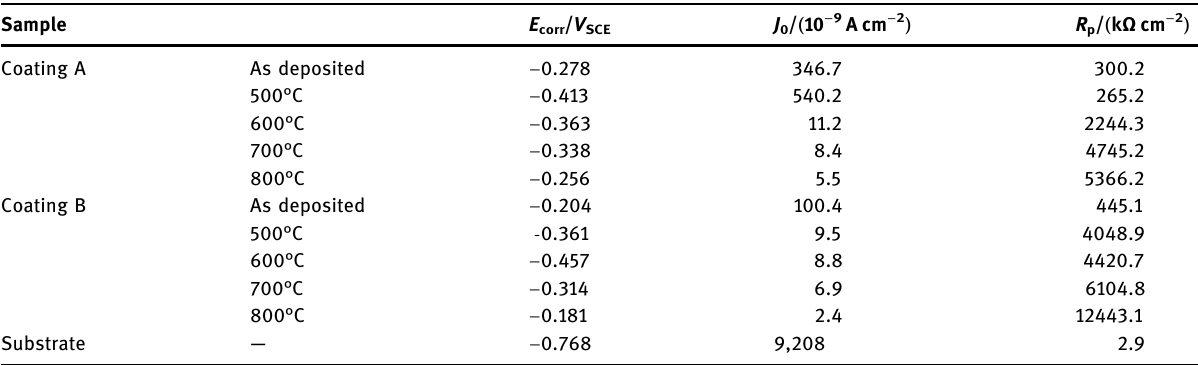
Table 3: Fitting data of Tafel polarization curve after soaking in 3.5% NaCI solution for coatings A and B Sample Coating